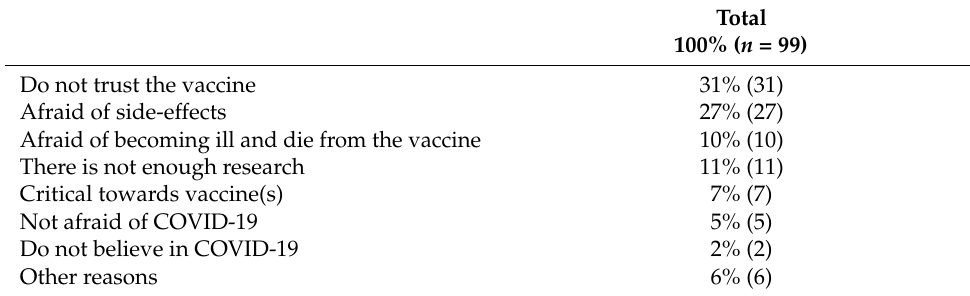
Table 3. Reasons for being negative to COVID-19 vaccination in a sample of PWUD ( n = 99).